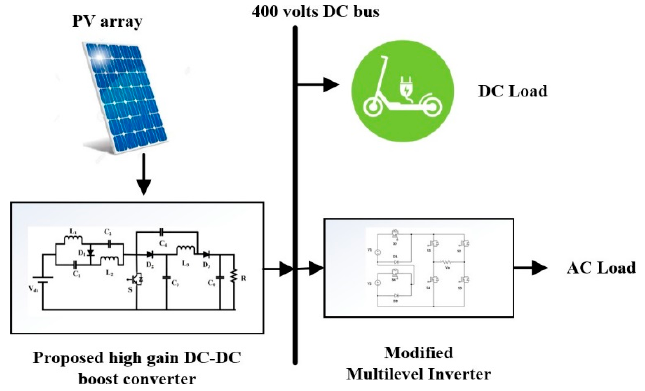
Figure 2. Layout of the proposed system .